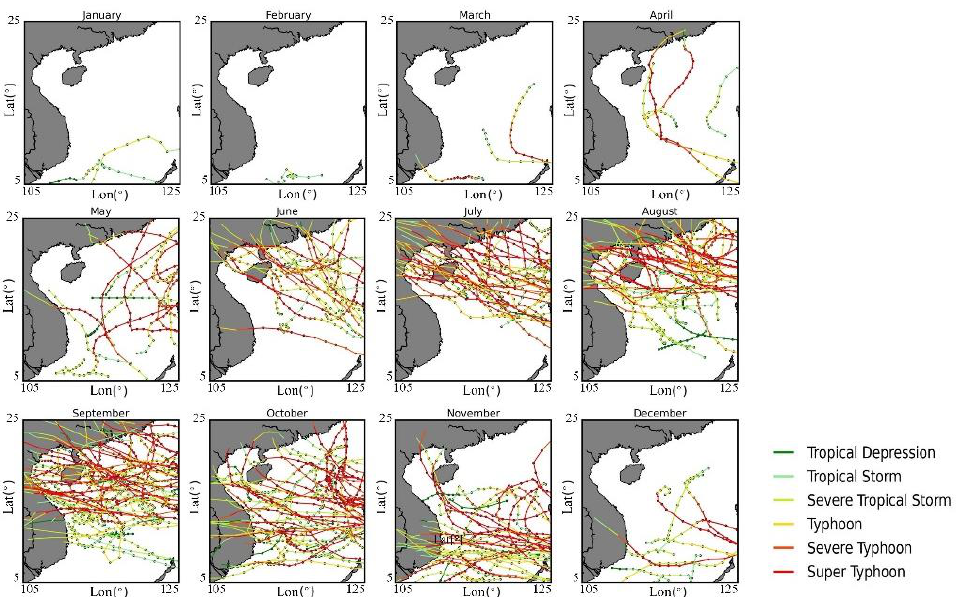
Figure 21. Regression curve of the wind speed at the Xisha Islands using the AM-GEV method.